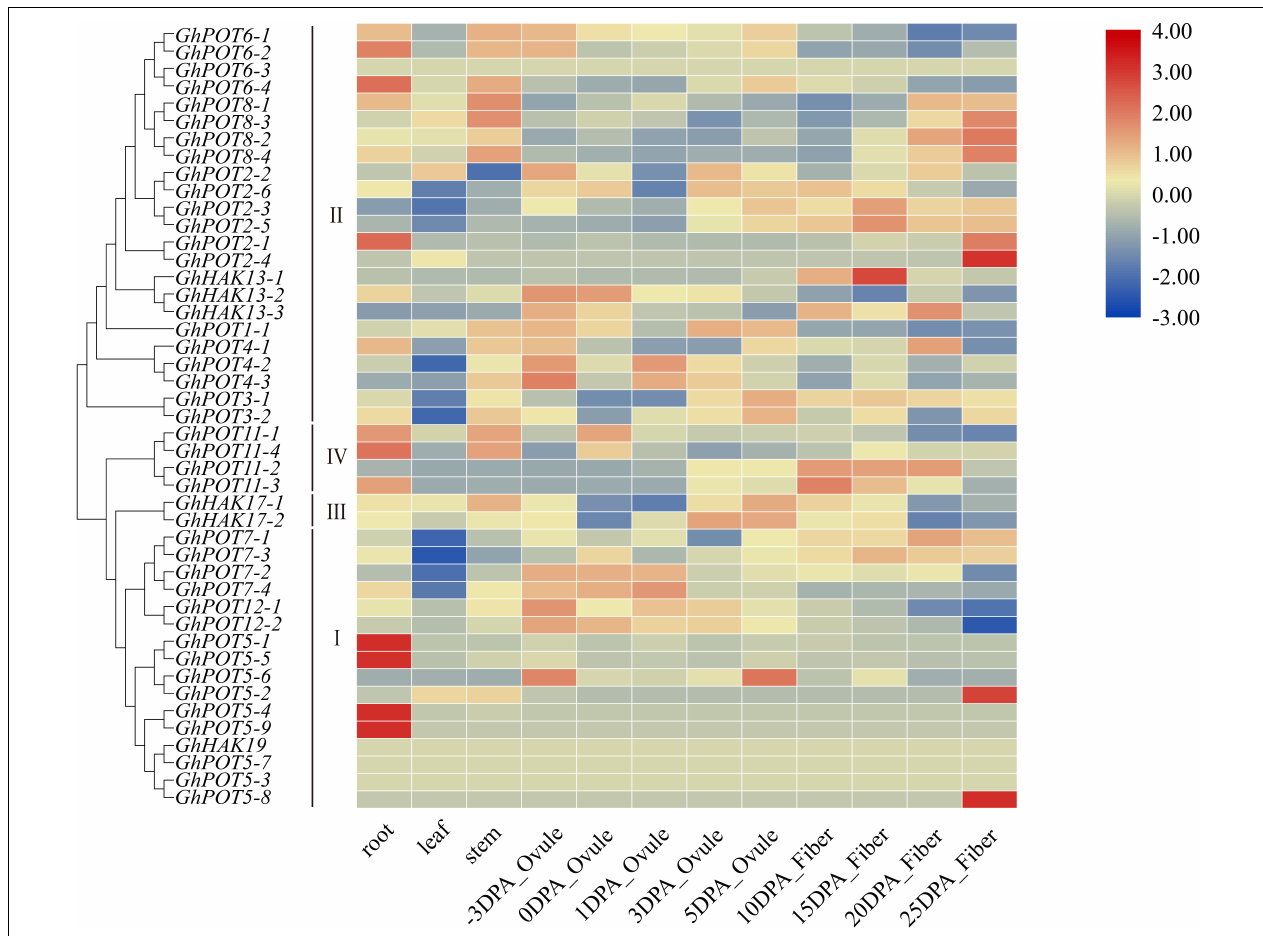
FIGURE 5 | Transcriptome data of GhPOTs in different tissues. DPA indicates days postanthesis. Gene names are shown on the left. The scale bar on the right shows the colors used to represent the log2-transformed FPKM values for each